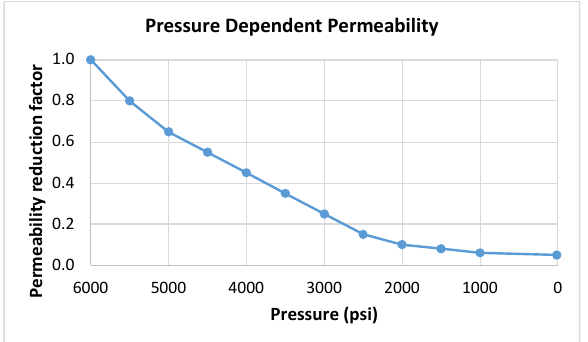
Figure 5. As the pressure drops in unconventional reservoirs, permeability tends to decrease due to the closing of meso- and microfractures. The permeability reduction factor is a unitless parameter that is multiplied by the initial absolute permeability to get the permeability for a given pressure. This curve represents the values found after history-matching.